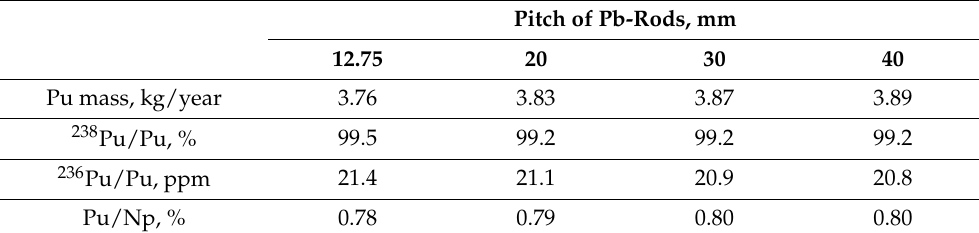
Table 3. Pitch of NpO 2 -rods t = 12.75 mm (Np mass = 484